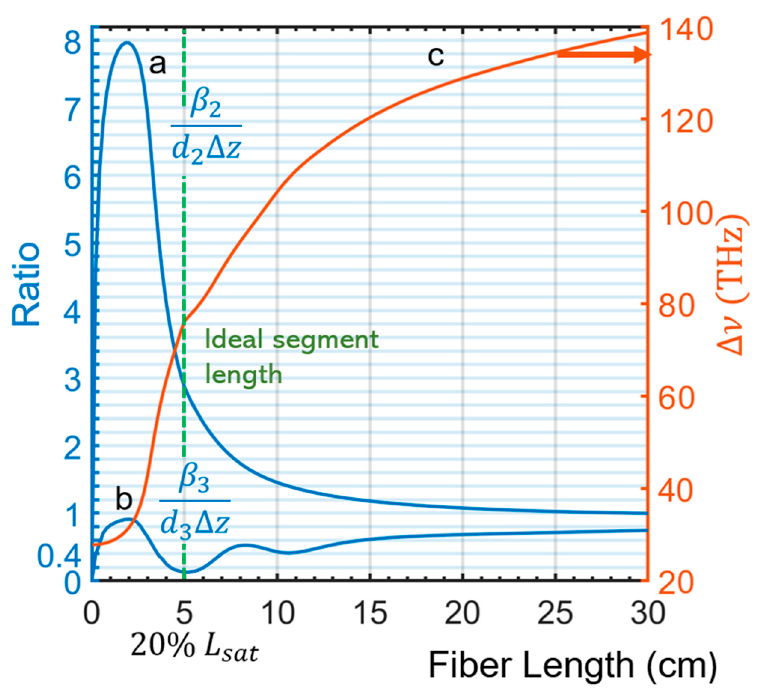
Figure 4. GNLSE simulation results. Curve a is the 1/e angular frequency bandwidth of the spectral energy density (in THz) versus propagation distance up to the normal dispersion fiber’s saturation length. Curve b is the plot of the ratio of the second-order spectral phase coefficient, β 2 , of the SCG pulse to that when there is no nonlinear effect ( d 2 ∆ z , versus propagation in the normal dispersion fiber. Curve c is the plot of the ratio of the third-order spectral phase coefficient, β 3 , of the SCG pulse to the third-order spectral phase coefficient in the absence of any nonlinear effect ( d 3 ∆ z ) versus the propagation in the normal dispersion fiber.